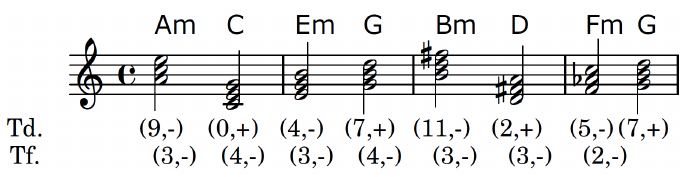
Figure 5. Output example, µ 1 = 0.8.